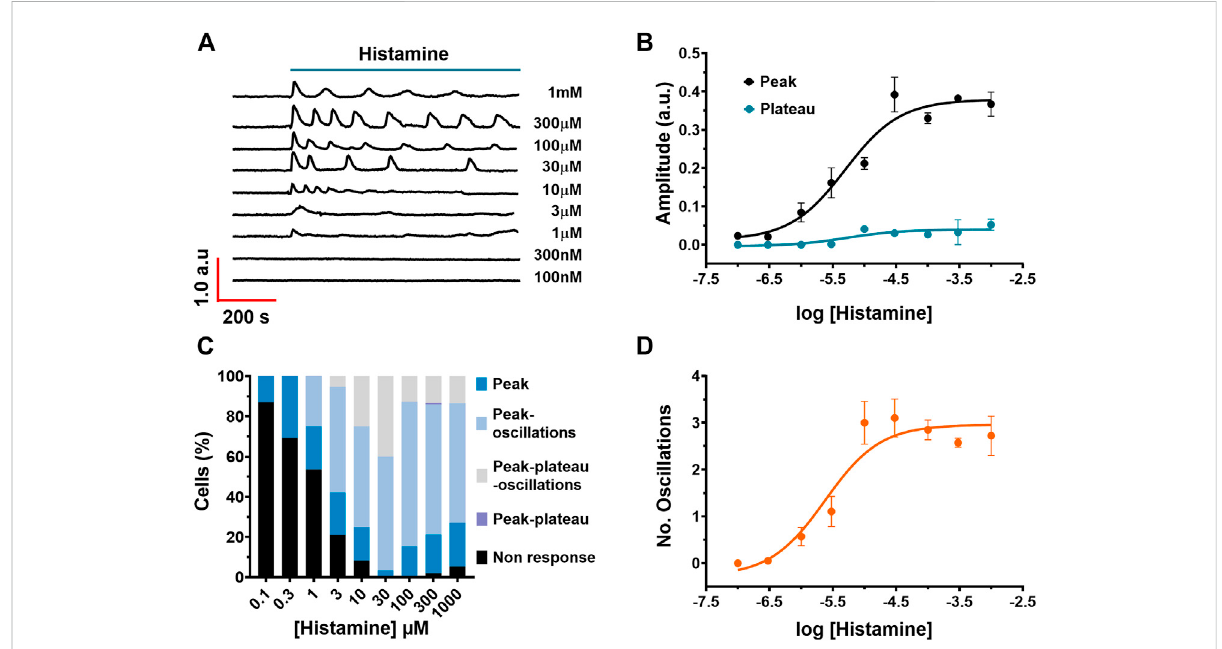
FIGURE 2 Concentration-dependent effect of histamine on Ca 2+ signalling in WI-38 human lung fi broblasts. (A) Typical intracellular Ca 2+ recordings in WI-38 cells loaded with FURA-2/AM exposed to different histamine concentrations ranging from 100 nM to 1 mM. The baseline of Ca 2+ tracings has been shifted to avoid their overlapping for representation proposes. (B) Non-cumulative concentration-response relationship. Data points are the mean ± SE of the initial Ca 2+ peak amplitude (black circles) or plateau amplitude (blue circles) plotted against the logarithm of histamine concentration. The continuous curves were obtained by fi tting the data to Eq. 1, as shown in Materials and methods, which yielded EC 50 values of 4.96 and 5.25 µM for peak amplitude (black line) and plateau amplitude (blue line), respectively. Data points were obtained of at least 19 cells. (C) Percentage of cells that presented each of the Ca 2+ response patterns indicated in function of histamine concentrations applicated to WI-38 fi broblasts. (D) Data points are the mean ± SE of the number of oscillations measured over the fi rst 400 s after histamine application, plotted against the logarithm of histamine concentration. The continuous curve was obtained by fi tting the data to Eq. 1, as shown in Materials and methods, which yielded EC 50 values of 2.38